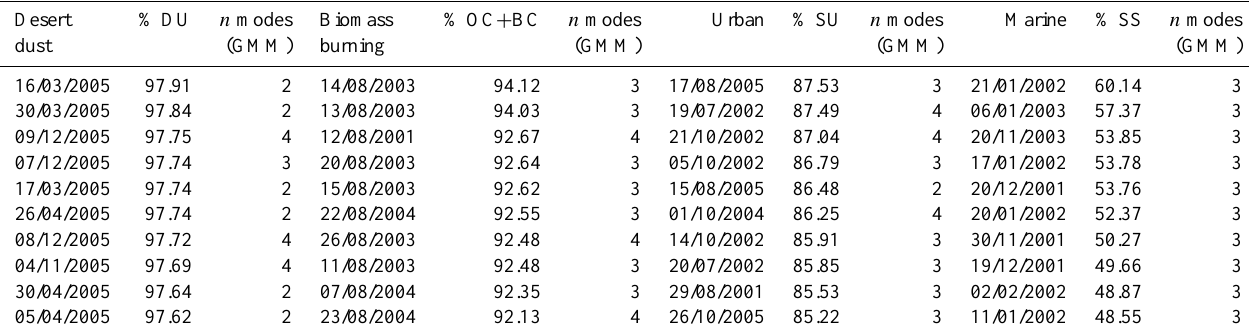
Table 4. The ensemble of the 10 most desert-dust-dominated AVSDs at Banizoumbou (Niger), biomass-burning-dominated AVSDs at Mongu (Zambia), urban-SU-dominated AVSDs at GSFC-Washington (US) and marine (sea salt)-dominated AVSDs at Lanai (Hawaii) according to GOCART chemical daily-averaged data. The optimal number of modes resulting from application of the GMM method is given in the last column for each dominant aerosol